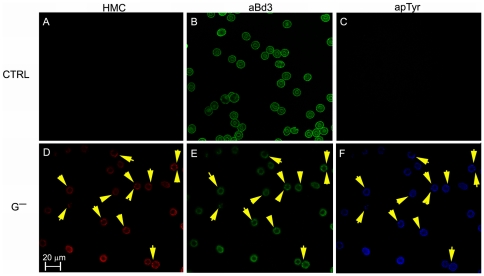
Confocal microscopy images of control and G6PD deficient RBCs.Panels A D: hemichrome (HCM) autofluorescence; Panels B, E staining with anti-band 3 antibody (aBd3); Panels C, F staining with anti-phosphotyrosine antibody (apTyr). Panels A, B, C control RBCs (CTRL). Panels D, E, F G6PD deficient red cells (G−). Yellow arrows indicate clusters containing hemicromes and co-stained with anti AE1 and anti-phosphotyrosine antibodies. Bar: 20 µm.